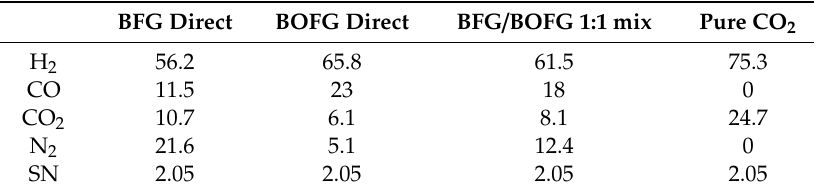
Table 2. Process feed gas composition in vol. % of gas utilization scenarios. BFG Direct BOFG